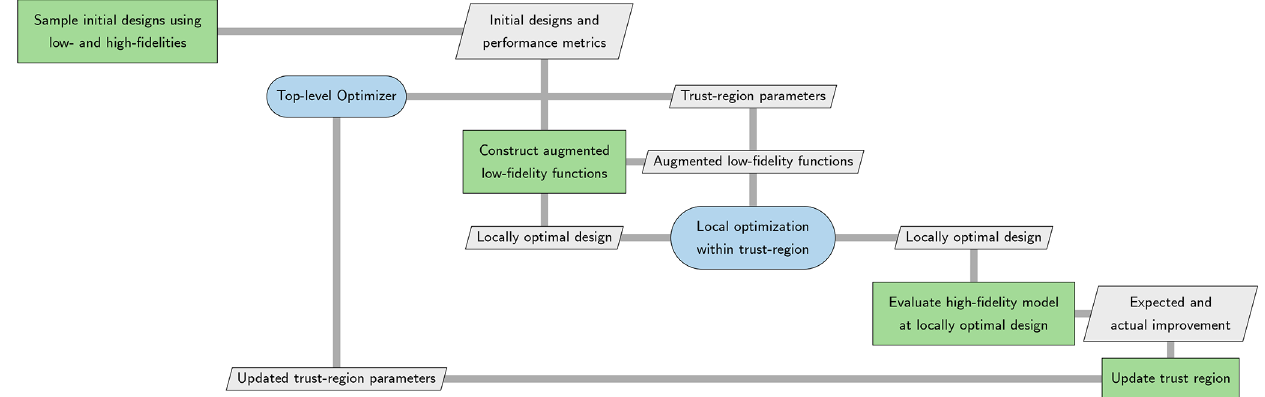
Figure 1. XDSM diagram of the trust-region method, specifically showing the top-level and inner-level optimizations.